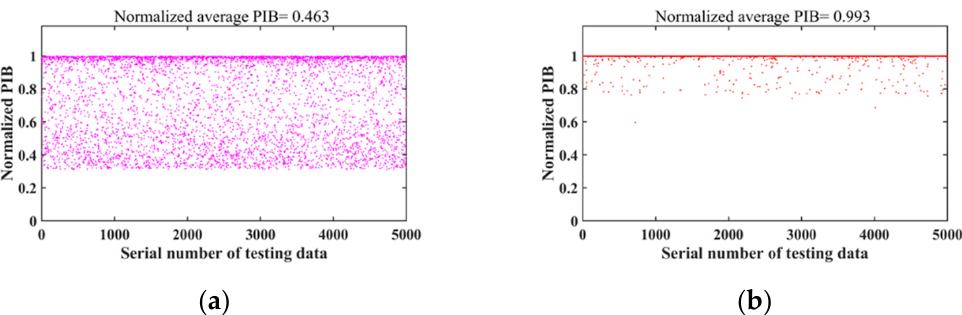
Figure 11. ( a ) Normalized average PIB of model 1 on the testing data; ( b ) Normalized average PIB of model 2 on the testing data.